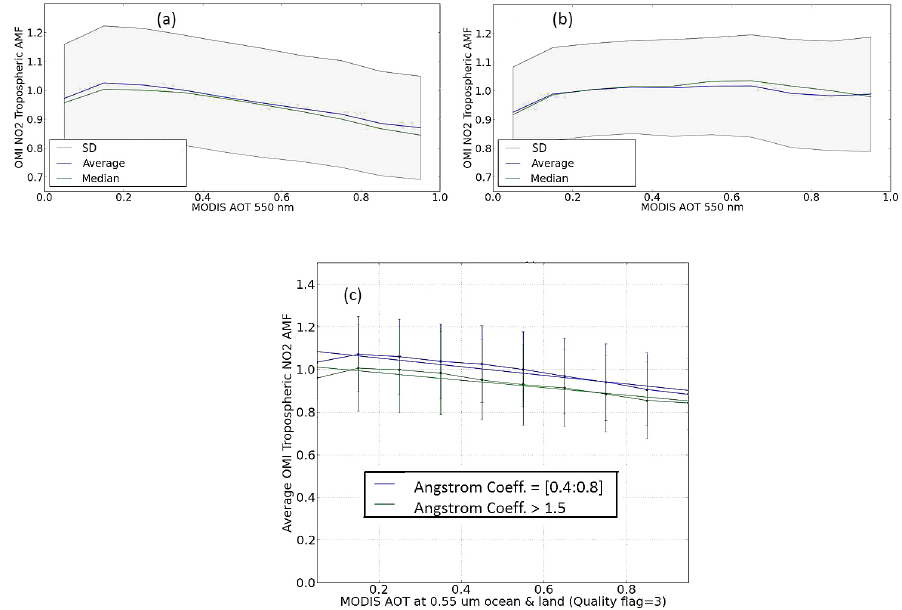
Figure 6. Tropospheric NO 2 AMFs from the OMI DOMINO v2 plotted against MODIS Aqua AOT. Statistics are computed over 3years (2005, 2006, 2007) and following the methodology described in Sect. 3: (a) summer (June, July, August), (b) winter (December, January, February), over East China, (c) summer, distinction between two ranges of MODIS Aqua aerosol Ångström coefficient. SD here is the standard